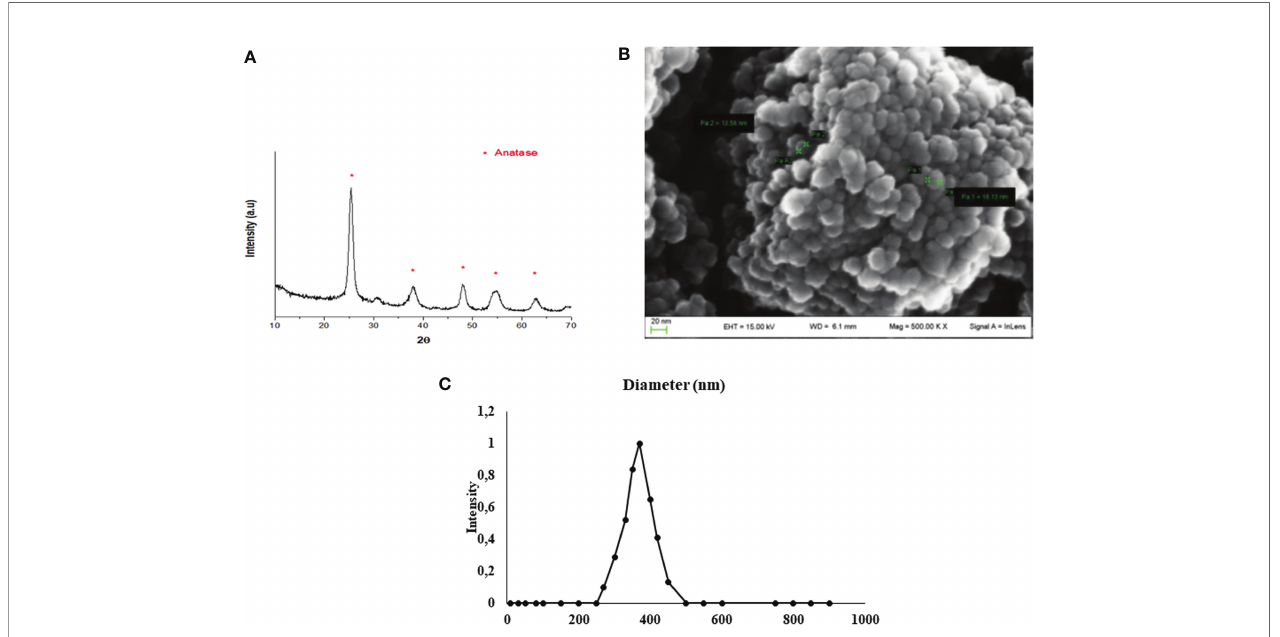
FIGURE 1 | TiO 2 NPs characterization. (A) XRD analysis: diffractogram con fi rmed the correct synthesis of TiO 2 NPs (JCPDS 00-001-0562) and * represents the peaks of TiO 2 NPs in anatase form. (B) SEM analysis: the mean size distribution of TiO 2 NPs in dry form was 20 ± 5 nm; image con fi rmed that TiO 2 NPs tend to form aggregates of submicrometric dimensions. (C) DLS analysis: mean hydrodynamic diameter of TiO 2 NPs at 10 µg/ml in culture